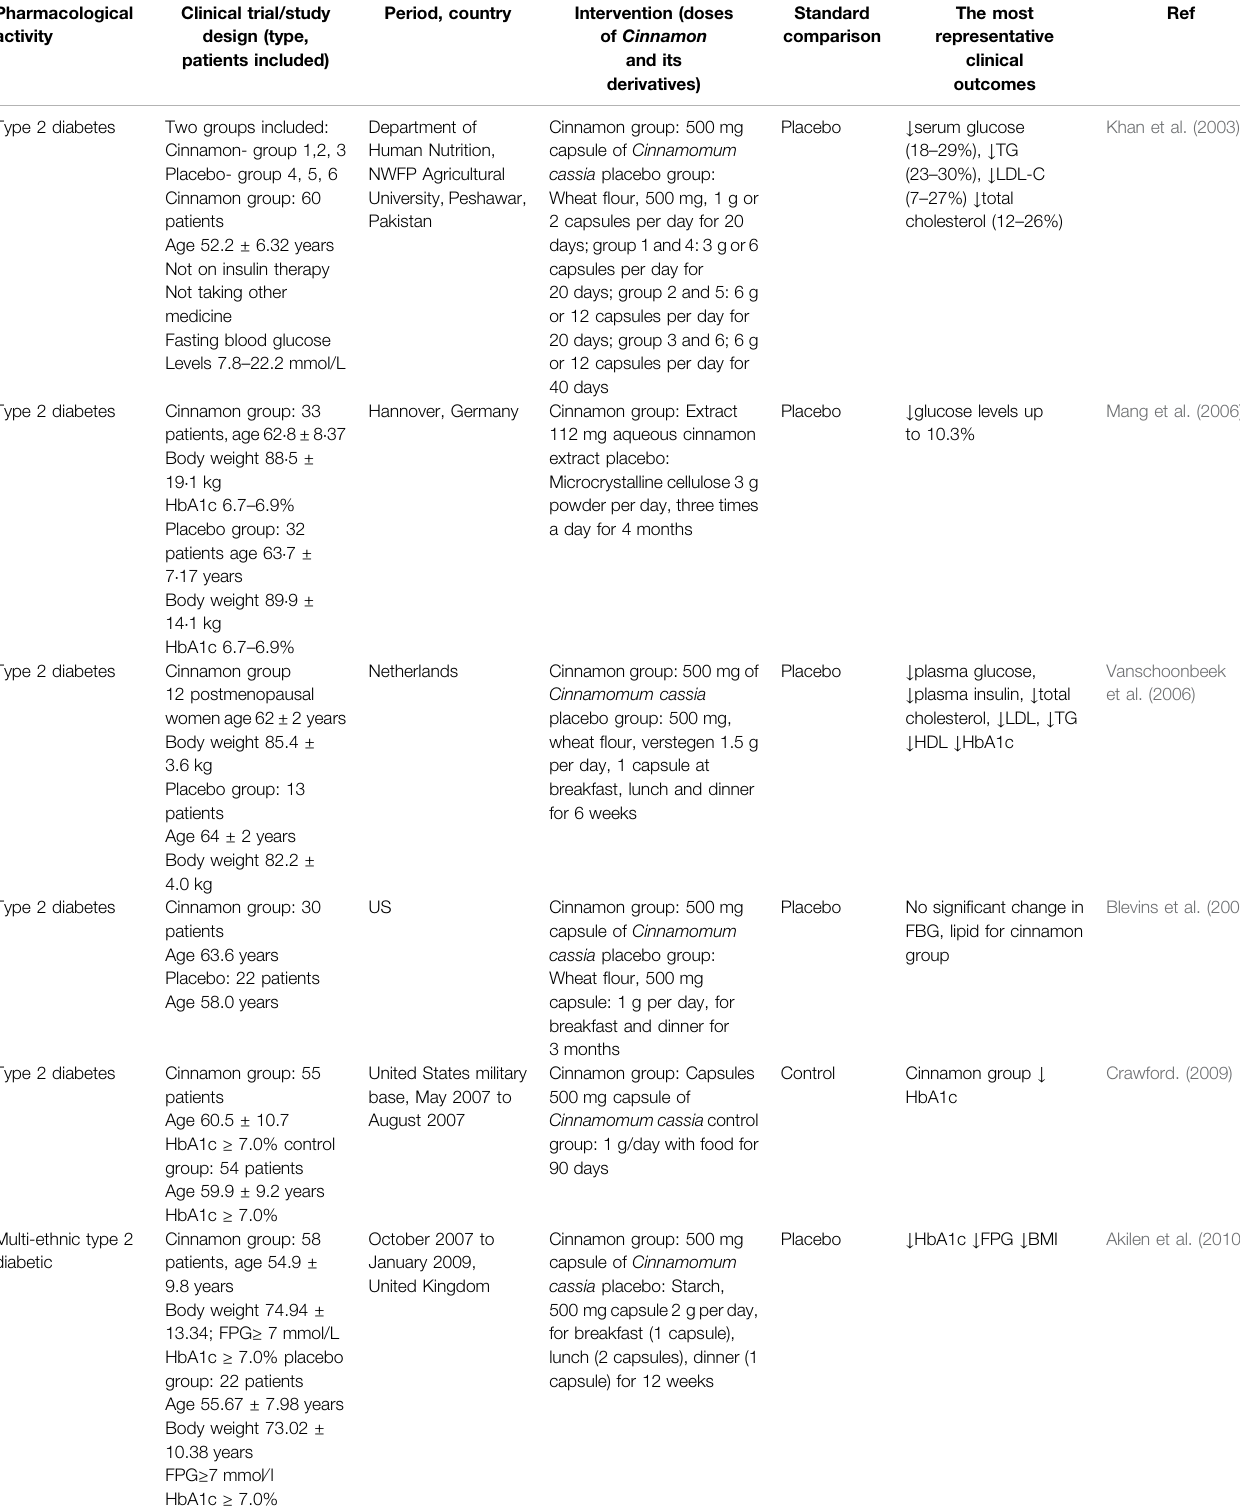
TABLE 3 | Description of recent clinical studies related to pharmacological activity of natural compounds from Cinnamomum species. Pharmacological